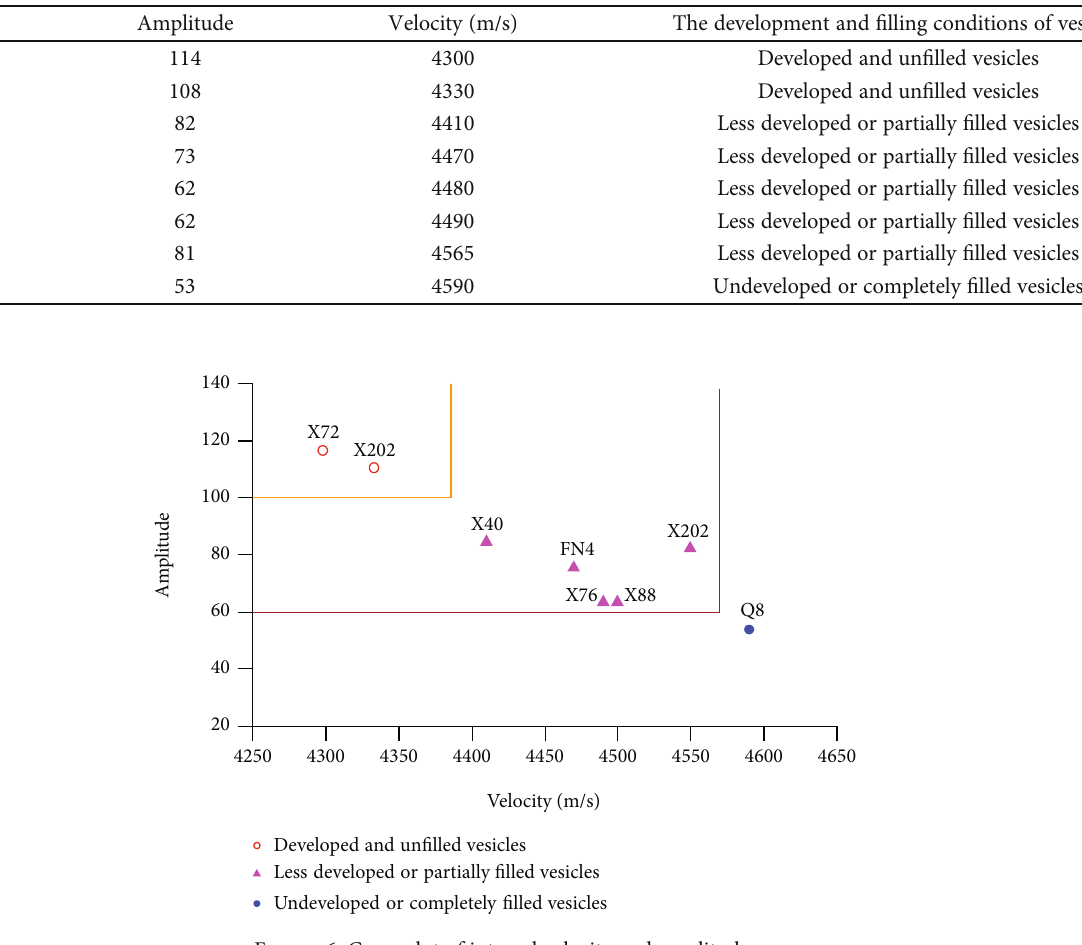
Table 1: Development and fi lling conditions of vesicles, and the velocity and amplitude data.